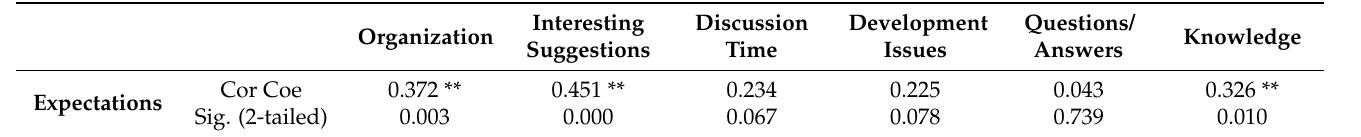
Table 12. Spearman’s rho correlation test of budding journalists’ expectations with the parameters of educational effective- ness from the “acquired knowledge organization”.